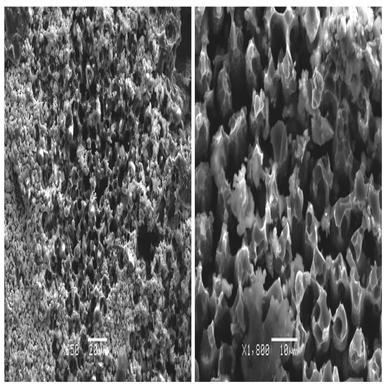
Details of the degradation of the fibres and matrix for samples tensile samples tested at 1000 °C.